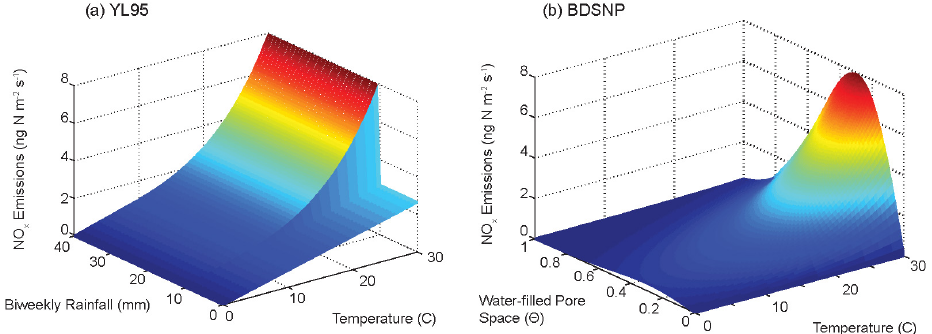
Fig. 2. A three-dimensional representation of the soil NO x emissions dependence on soil moisture and temperature from (a) YL95 and (b) BDSNP. The color scheme is a visual aid and follows the vertical axis.